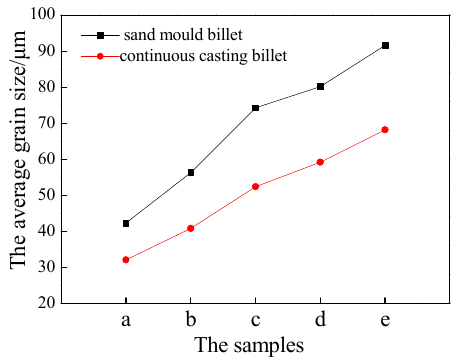
Figure 11. Grain size statistical analysis result: ( a ) original microstructure (×100) and ( b ) microstructure (×100) after processing.